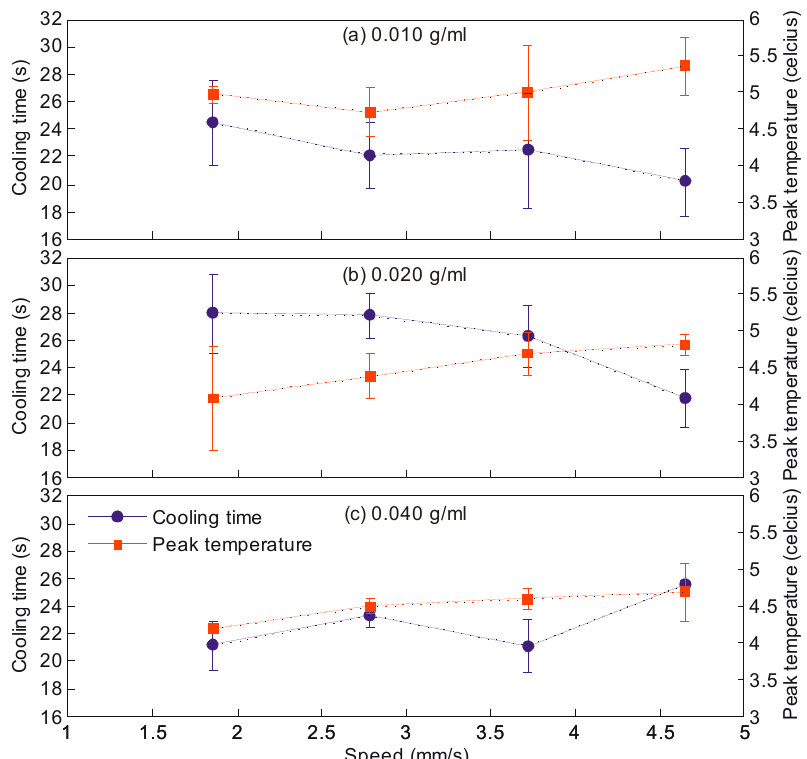
(orange line) with reference to the speed of the magnet. The four horizontal points represent the speed of 1.86, 2.79, 3.72 and 4.65 mm/s. Panel ( a – c ) represent the trend at three different concentrations of iron oxide particles. All the droplets have the volume of 5 μ L. iron oxide particles. All the droplets have the volume of 5 µ